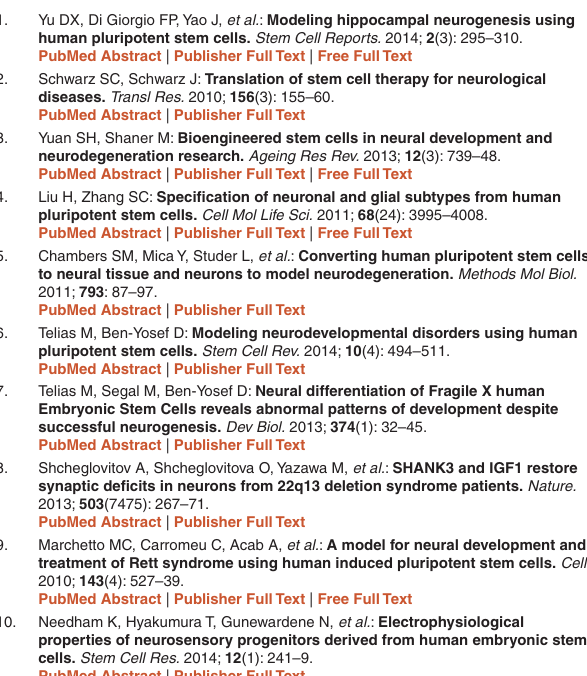
16. Rodrigues GM, Matos AF, Fernandes TG, et al. : Integrated platform for production and purification of human pluripotent stem cell-derived neural 17. Birenboim R, Markus A, Goldstein RS: Simple generation of neurons from human embryonic stem cells using agarose multiwell dishes. J Neurosci 18. Banda E, Grabel L: Directed Differentiation of Human Embryonic Stem Cells into Neural Progenitors. Methods Mol Biol. 2014.